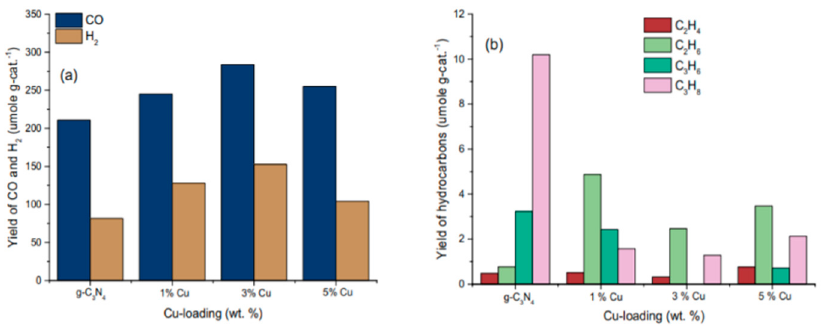
Figure 29. Yield of ( a ) CO and H 2 and ( b ) higher hydrocarbons using Cu/g-C 3 N 4 . Copyright (2017), reprinted from [48] with permission from Elsevier.